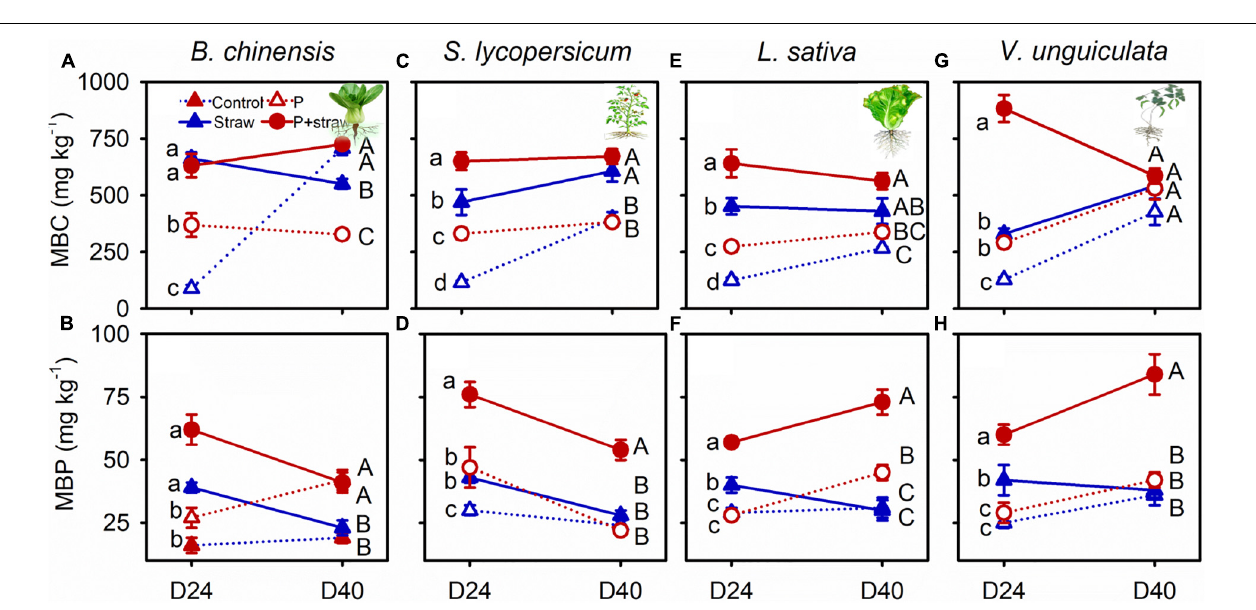
FIGURE 3 | Effects of straw addition and P fertilization on MBC (microbial biomass C) and MBP (microbial biomass P) in soil with B. chinensis (A,B) , S. lycopersicum (C,D) , L. sativa (E,F) , and V. unguiculata (G,H) after days 24 and 40 days. Control: no fertilizer P or straw; straw: no P but with straw addition; P: fertilizer P at